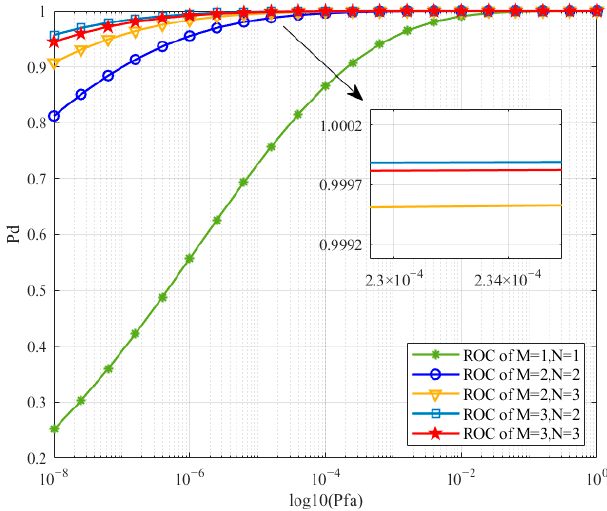
Figure 10. Average ROC curves for different antenna amounts.